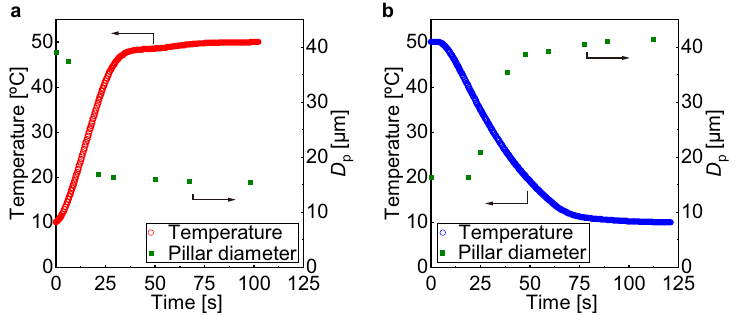
Figure 6. Response time measurement of the temperature of the Peltier plate and the pillar diameters. The open circles represent the temperatures recorded over time after the preset temperature was abruptly changed ( a ) from 10 °C to 50 °C and ( b ) from 50 °C to 10 °C at t = 0. The solid rectangles represent the variation of the pillar diameters in response to the temperature